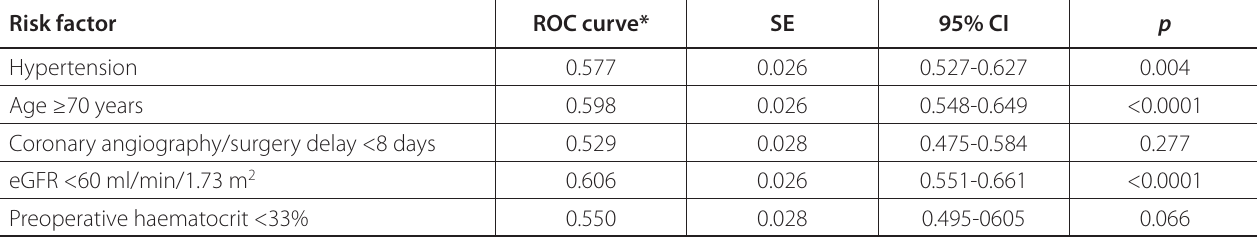
Table 4. Prediction model of acute kidney injury using the risk factors resulted from the multiple logistic regression analysis. Risk factor ROC curve*